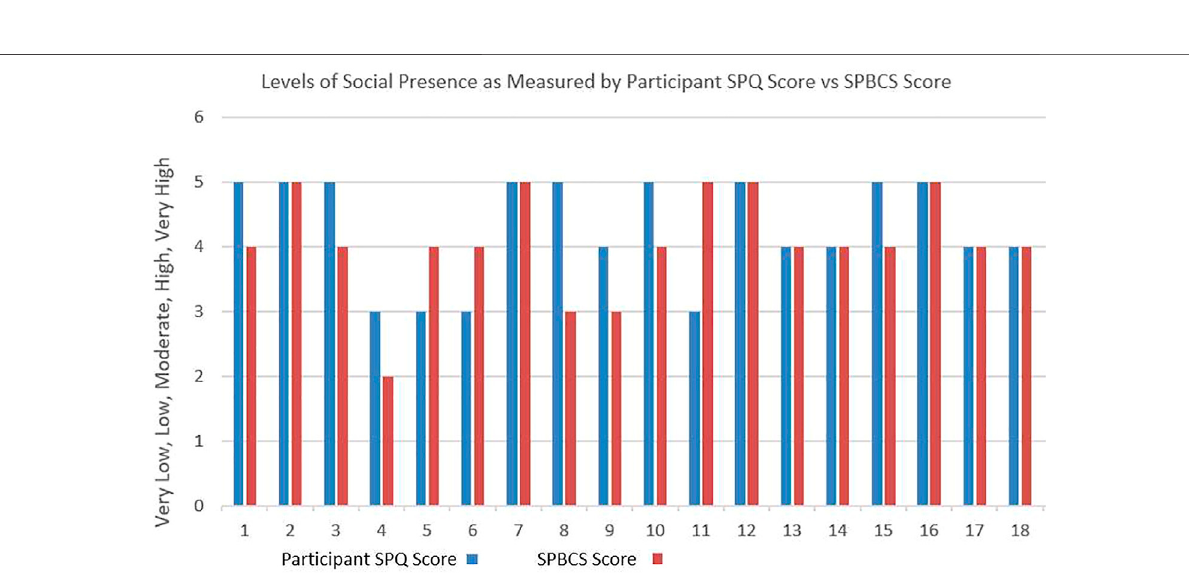
Frontiers in Virtual Reality |